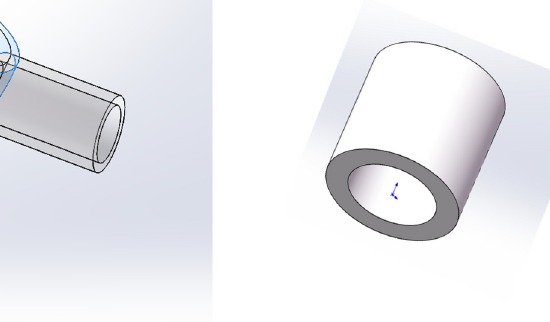
Figure 1. Each member of the choke valve.